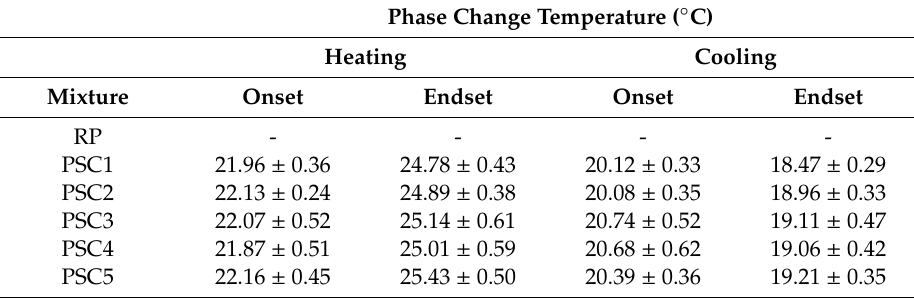
Table 3. Phase change interval and latent heat of studied